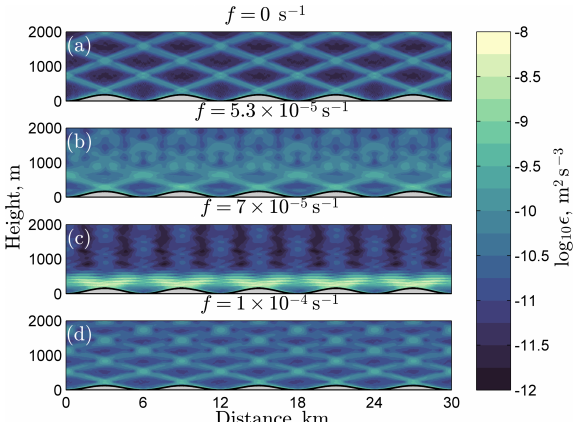
Figure 2. 2-D maps of the tidally-averaged turbulent kinetic energy (TKE) dissipation rates (m 2 s − 3 ). Data are from simulations where γ = 0.68, λ x = 6 km, and four values of f : (a) f = 0, (b) f = shows height above the sea-floor (m).